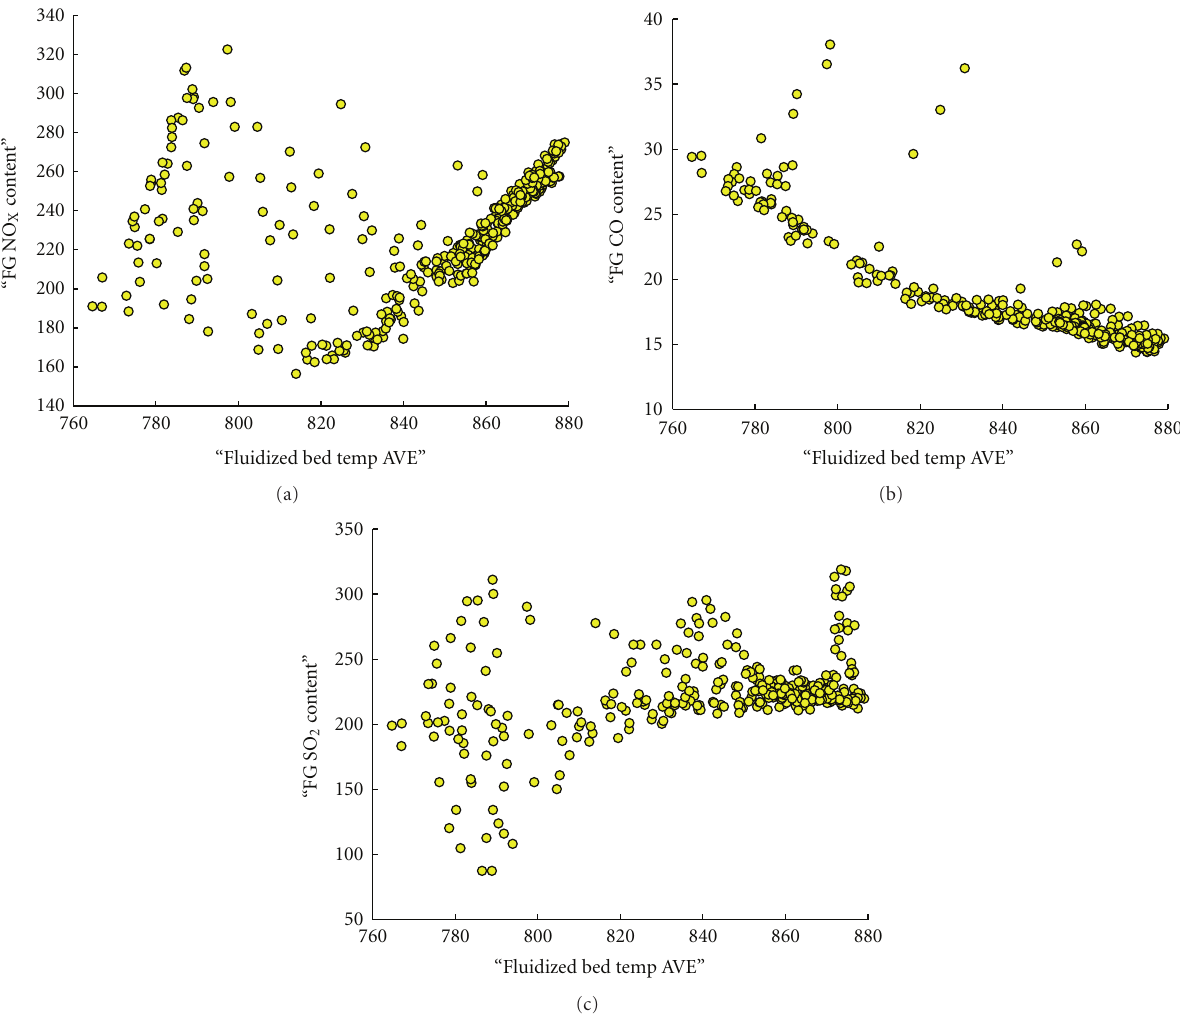
Figure 3: Emission models after creating a 24 ∗ 16 SOM. (a) NO x , (b) CO, and (c) SO 2 content [mg/Nm 3 ] of flue gas (FG) as a function of the bed temperature [ ◦ C] by using the reference vectors of SOM